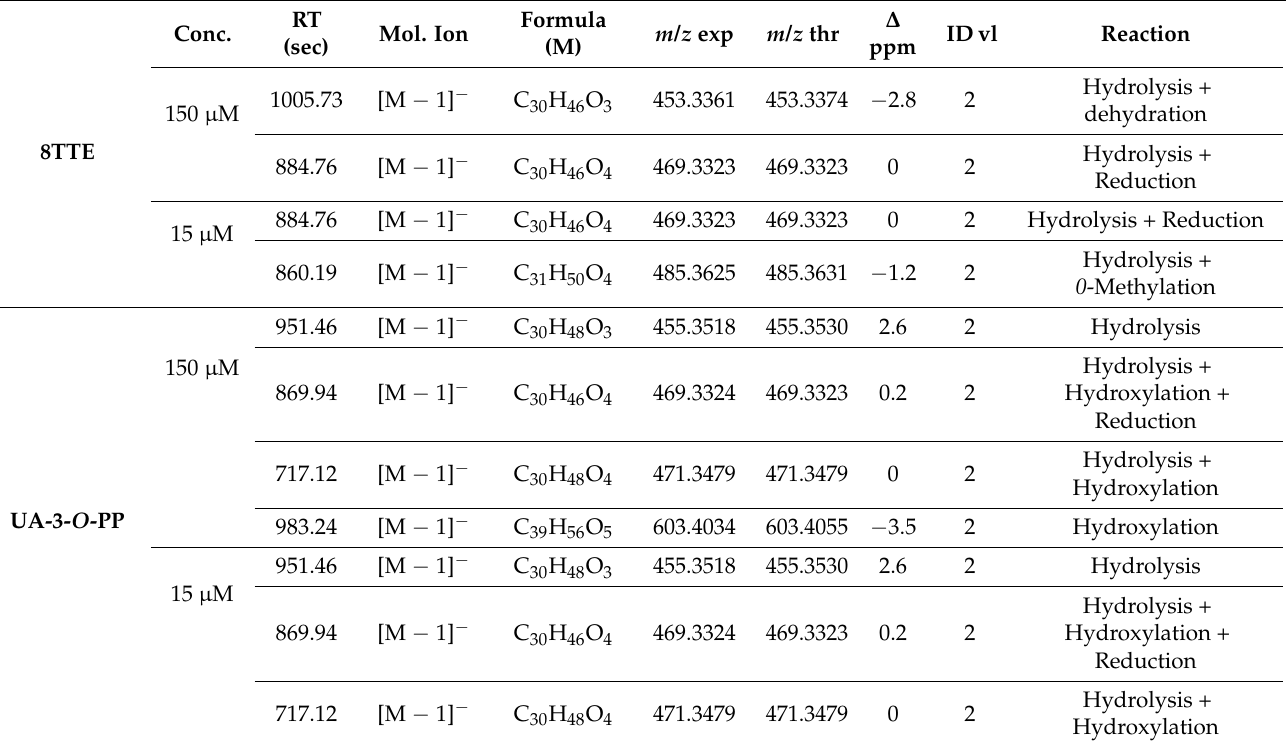
Table 5. Identification, prediction level and metabolic reactions involved of the detected metabolites.